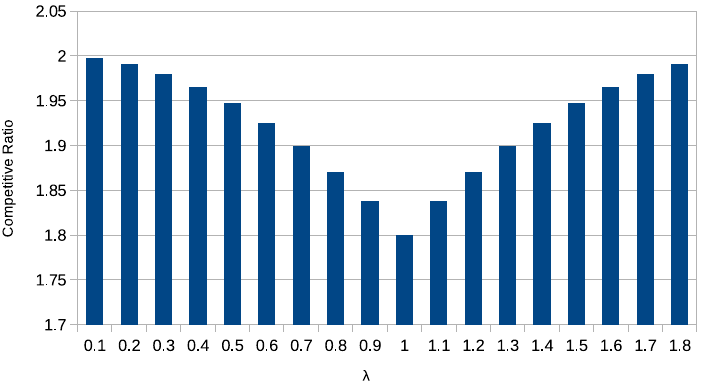
Figure 1. Overall optimal competitive ratios for given λ